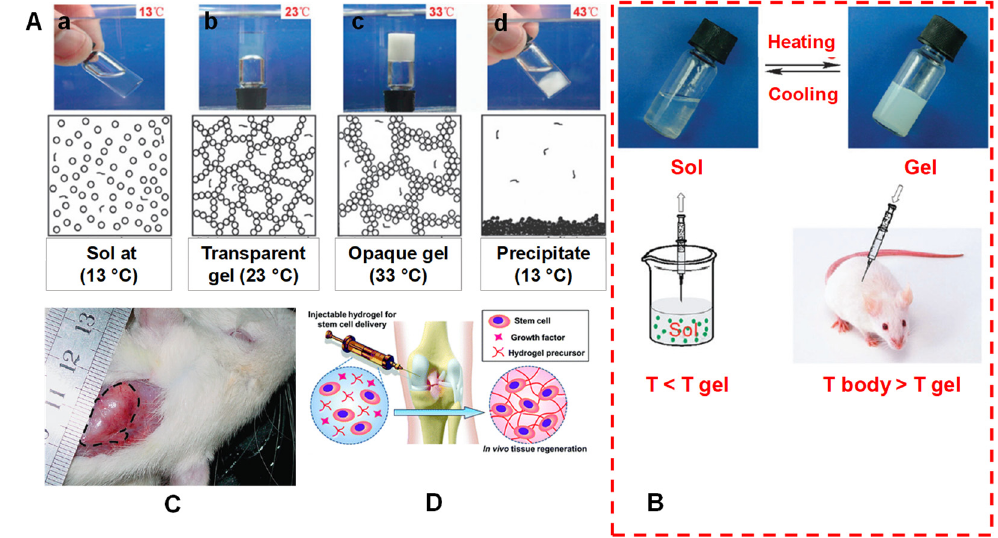
Figure 3. ( A ) Mechanism of a spontaneous thermos gelling of the appropriate block copolymers in water via the formation of a “micelle-network”. For simplicity, a micelle is denoted by a circle, although a micelle owns the core-corona structure and is deformable. ( a ) The aqueous system takes on a sol-like suspension at a low temperature; ( b ) the micelles are aggregated into a percolated micelle network in which each micelle is still intact, but micelle aggregation occurs due to the hydrophobic interaction between micelles, and the solvent loses flowability, leading to the so-called sol–gel transition; ( c ) the micelle network is coarsened until the mesh size is in the order of the visible light wavelength, and the gel is thus opaque; ( d ) the micelle structure is destroyed due to over-hydrophobicity of the sample at higher temperatures, eventually leading to macroscopic precipitation. ( B ) A schematic illustration of an injectable hydrogel system exemplified by a physical thermos-gelling material. T gel is the sol–gel transition temperature. The polymers could be dissolved in water to form a sol at low temperatures. Bioactive molecules or cells indicated by the dots in the lower-left image can be incorporated by simple mixing with sols. The sols are injectable, and in situ gelling takes place after injection if the gelling temperature is lower than the body temperature T body. As a result, the encapsulation of drugs or cells and the implantation of biomaterial are carried out with minimal surgical invasiveness. ( C ) A global observation of a physical gel formed underneath the skin of a rat. The image was taken 21 days after subcutaneous injection of an aqueous solution of PLGA–PEG–PLGA copolymer. The gel region is emphasized by the dashed line. Adapted with permission from ref. [11]. Copyright © 2008 Chemical Society Review . ( D ) Injectable hydrogel for stem cell therapy. Adapted with permission from ref. [15]. Copyright © 2019 The Royal Society of Chemistry